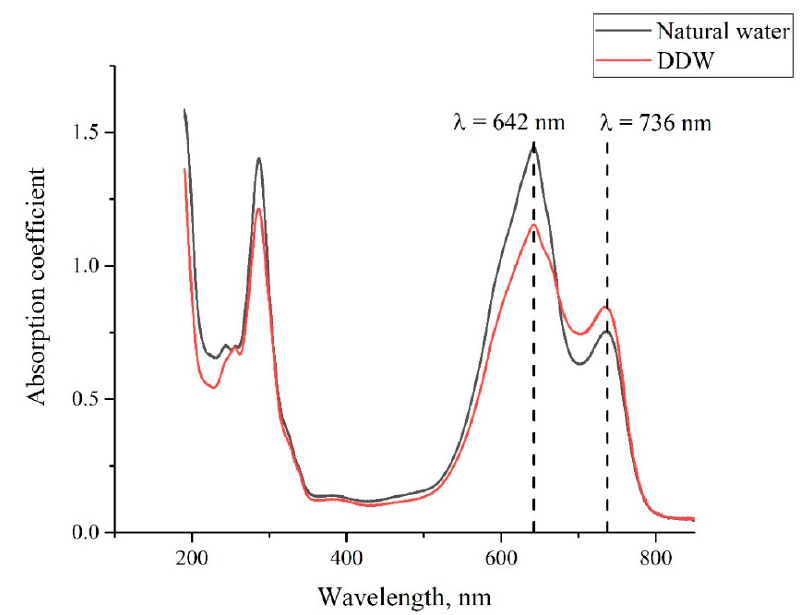
Figure 4. The absorptivity spectrum of Nafion membrane immediately after removing the plate out of the MB solution with weight concentration 0.015 mg/mL based on natural water, and